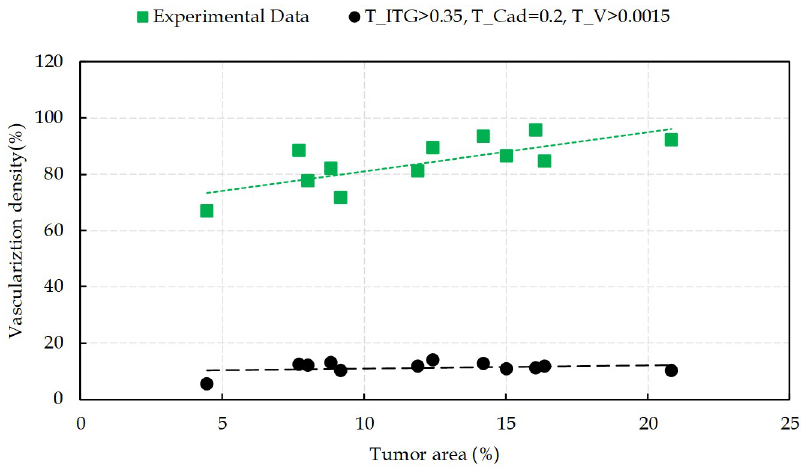
Fig 17. Intratumoral vascularization density as a function of the tumor area, resulting from interventions in signals activation. Comparison between simulation results from present work with experimental data reported in [128].